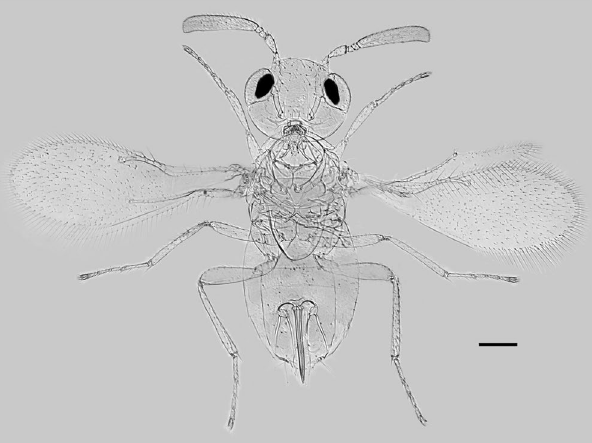
Figure 4. Eretmocerus furuhashii Rose: composite image from 4 female paratype specimens (Irvine 108, Orange Co. California, USA. 29.vii.1982 ex Parabemisia myricae . Ferrentino + Woolley col. BMNH(E) 1996-136). Scale bar = 0.1 mm. The image was produced using AutoMontage (Synoptics Ltd, Cambridge, UK) stacking imaging software on a set of images taken with a Q-Imaging RoHS camera and processed using Adobe Photoshop CC